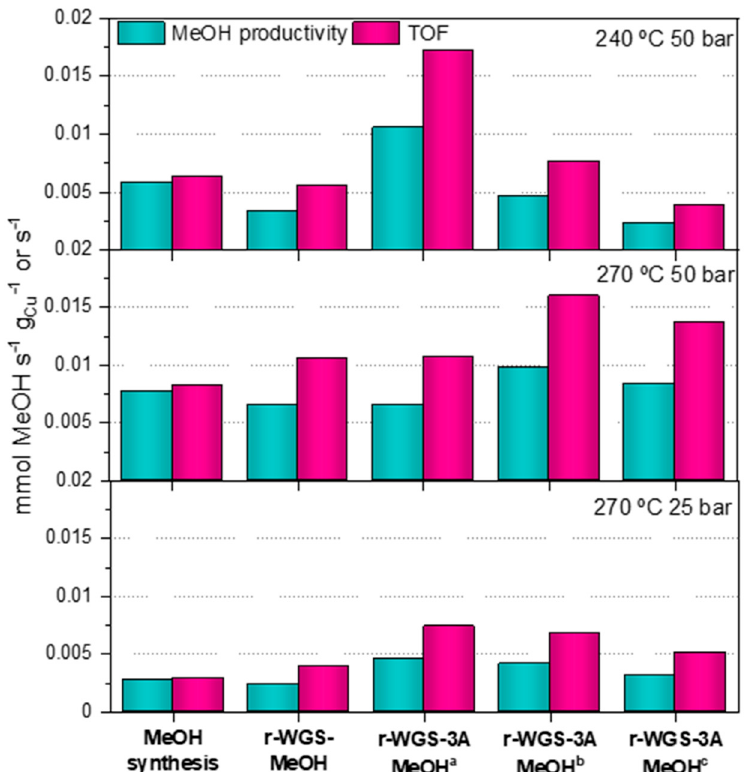
Figure 8. Methanol productivities and TOF obtained with the different bed configurations at different conditions of pressure and temperature: 240 ◦ C—50 bar, 270 ◦ C—50 bar and 270 ◦ C—25 bar. a First collected data set of the experiment (TOS near to 0). b Value at TOS near to 2, within the dynamic state. c Value after the stationary state was reached (saturation of the sorbent).